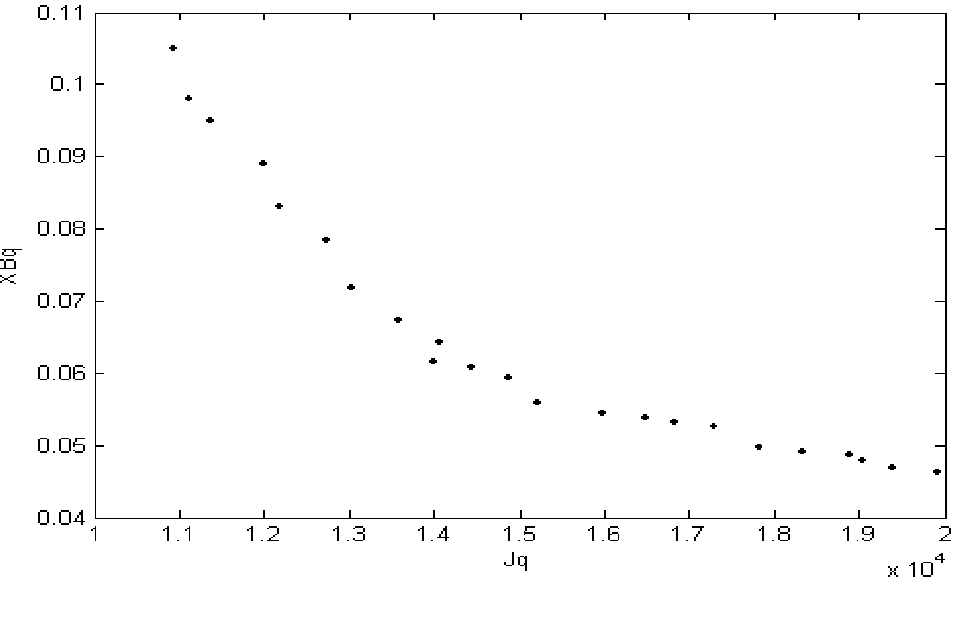
Figure 1. Non-dominated Pareto front for artificial